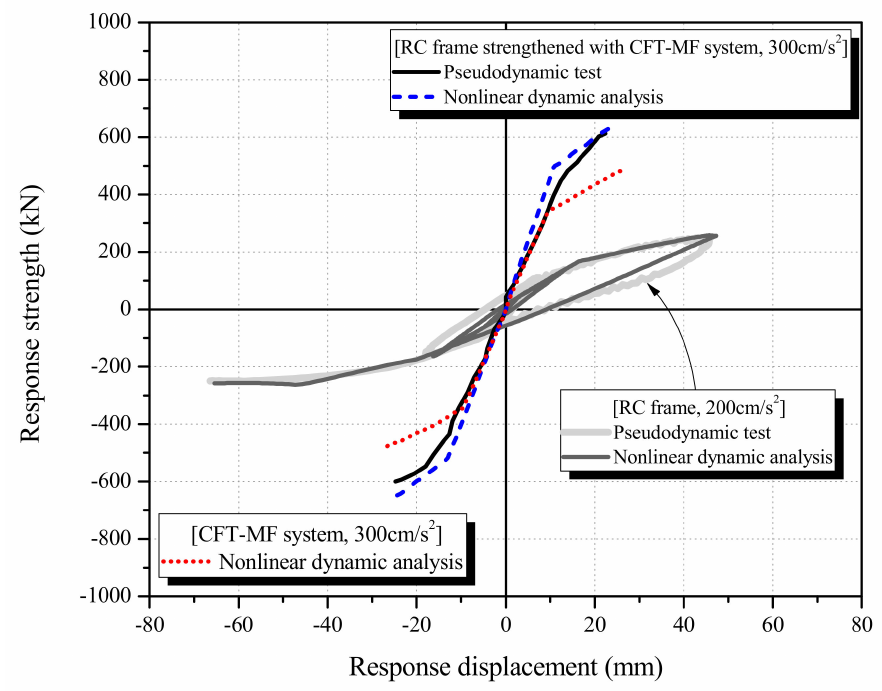
Figure 25. Comparison of contribution of seismic response load of each member to seismic response displacement (RC test frame retrofitted with CFT-MF system, CFT-MF system, and RC test frame with no reinforcement